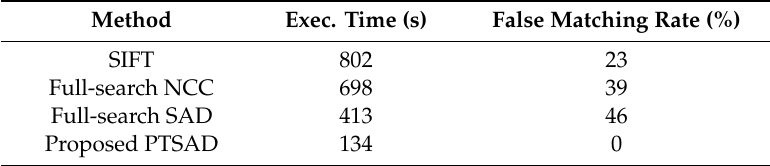
Table 4. Execution time and false matching rate of di ff erent matching methods for the second video. Method Exec. Time